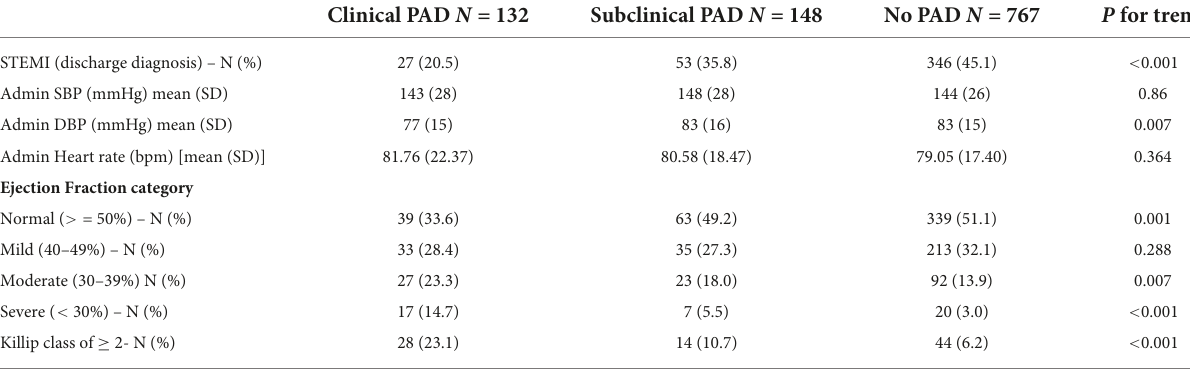
TABLE 2 Clinical